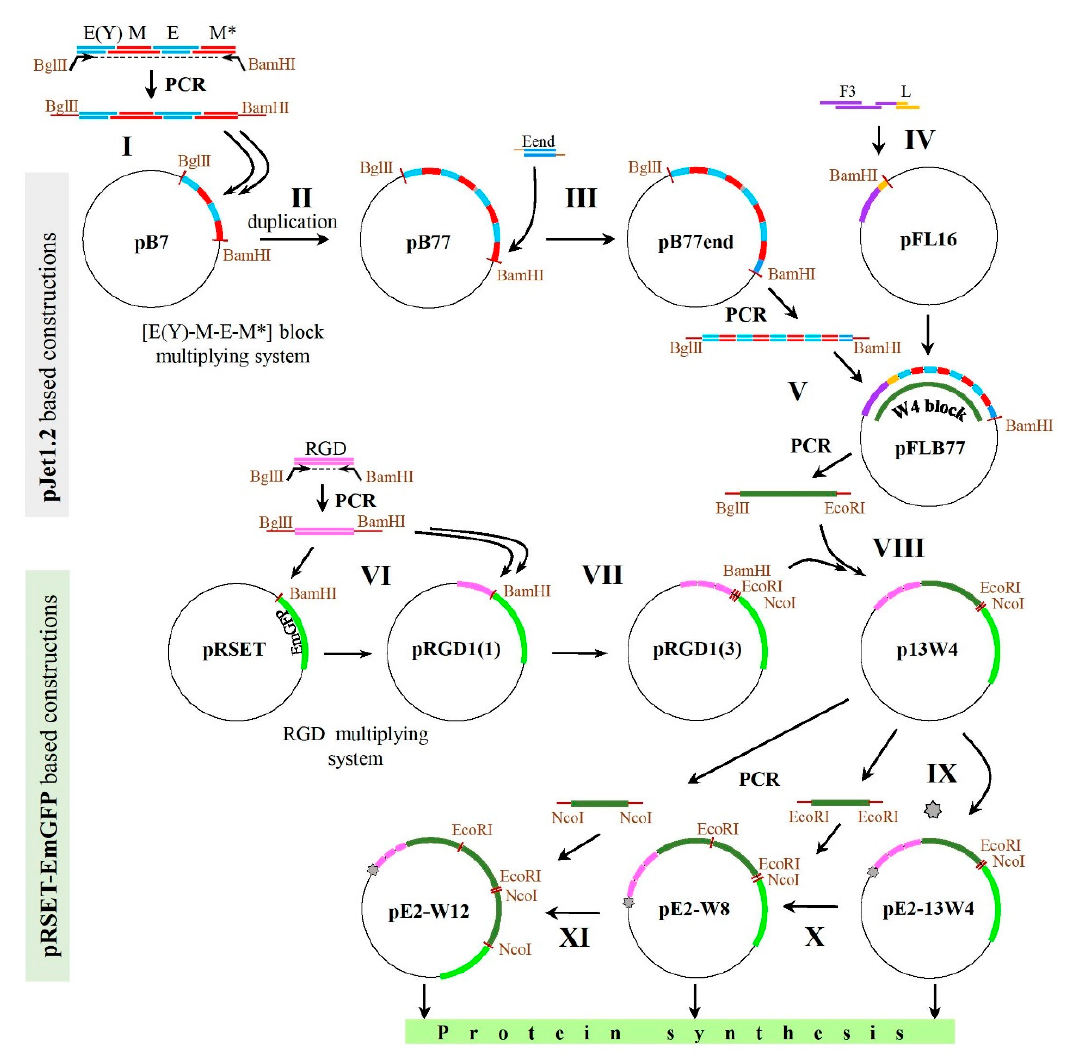
Figure 4. Overall scheme for constructing the plasmids used in the work. All constructs are based on the pJET1.2 vector backbone (at the top) or the pRSET-EmGFP backbone (at the bottom). The colour codes are used to delineate the following amino acid sequences: E(Y)-[VPGYG-VPGSG], E-[(VPGSG) 4 ], M and M*-[DKDGDGTITTKEL], Eend-[(VPGSG) 2 ], F3-KDEPQRRSARLSAKPAPPK-